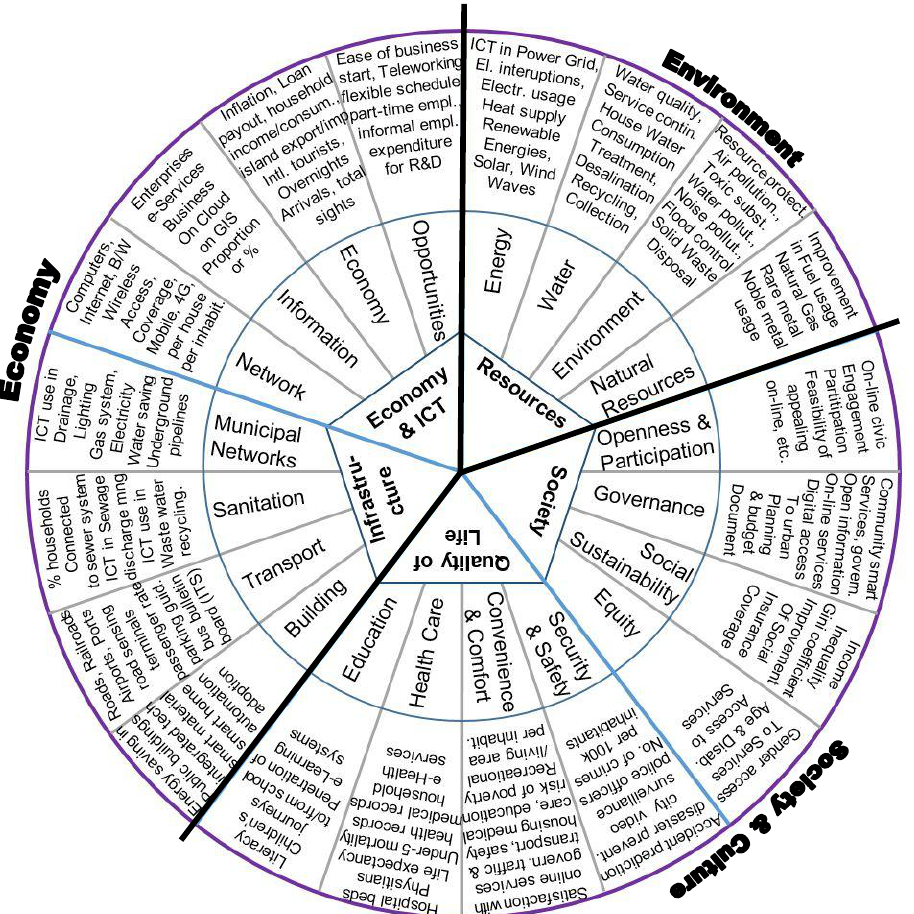
Figure 1. The KPI Wheel proposed by the authors [Pantazis et al, 2018], that also corresponds to the three UN main directions (in